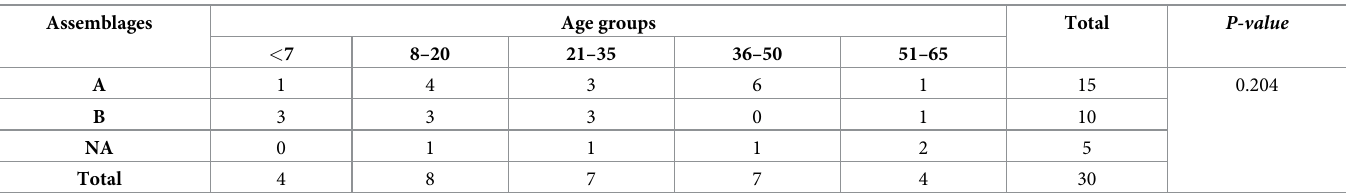
Table 3. The correlation between assemblages and age groups.